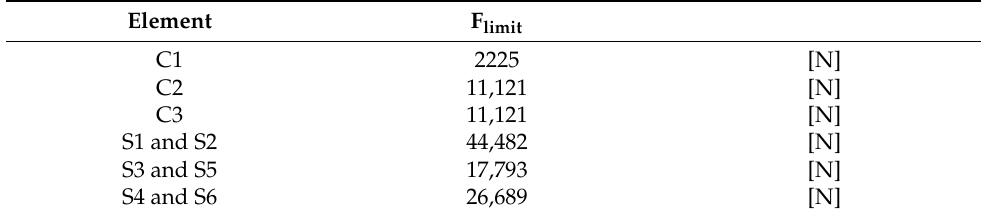
Table 2. Declared strength of the